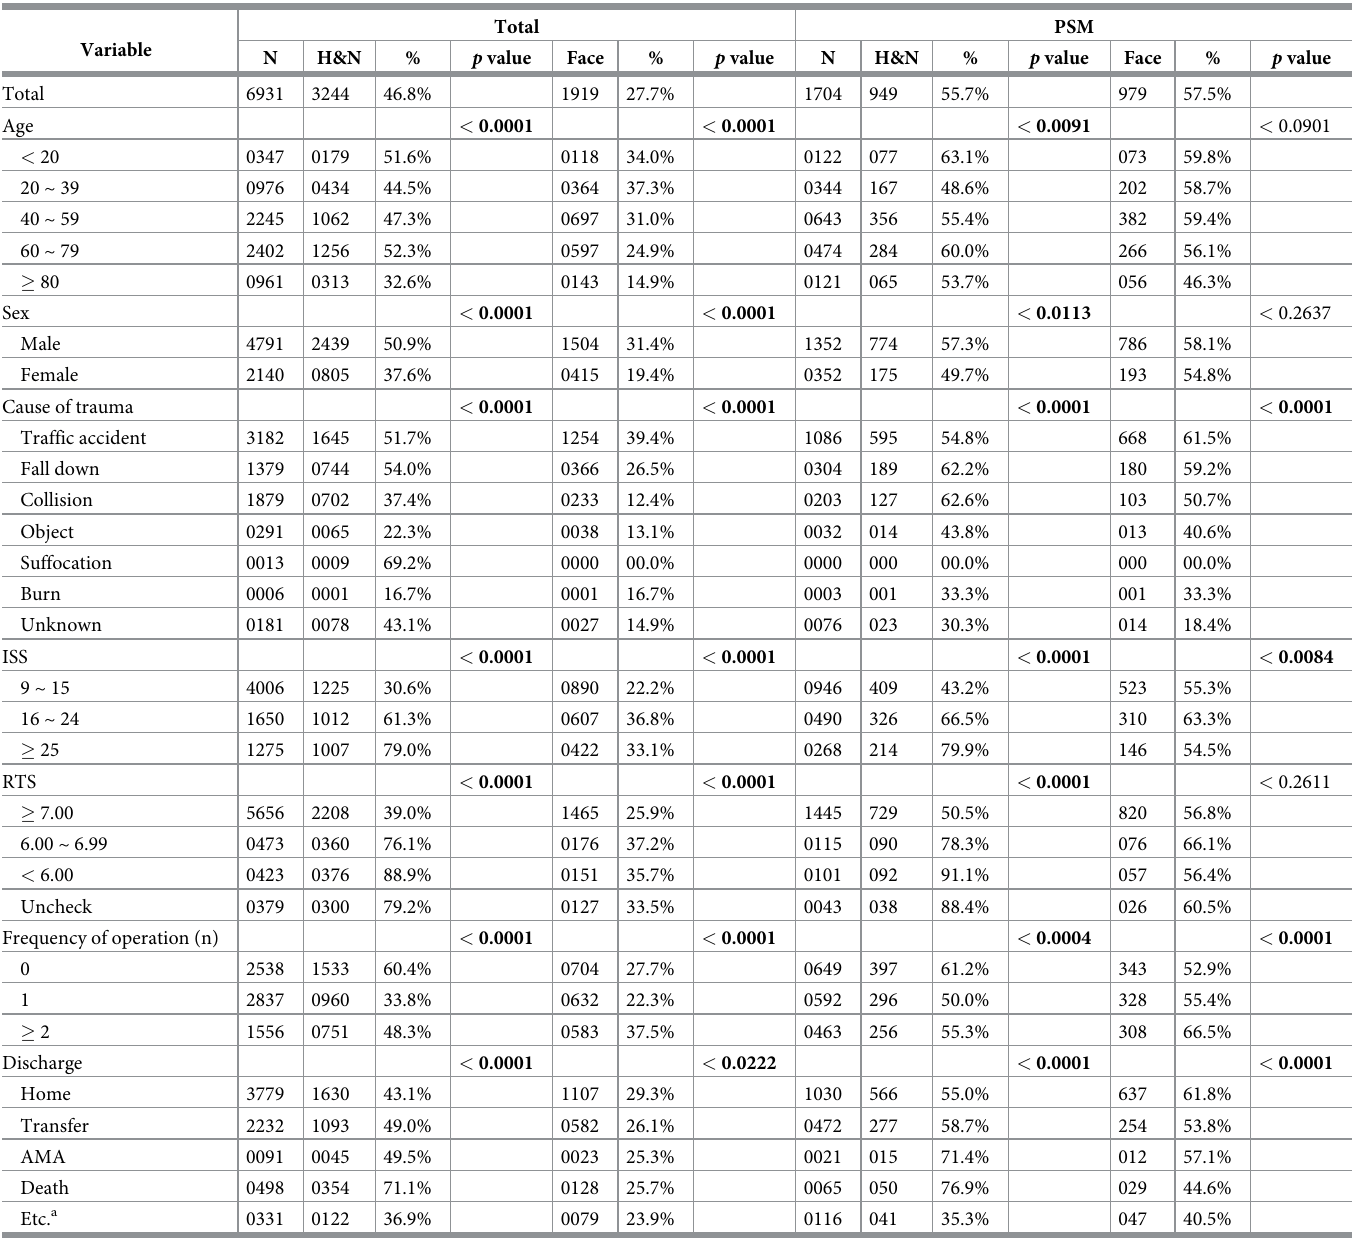
Table 3. Analysis of Abbreviated Injury Scale (Head and neck,